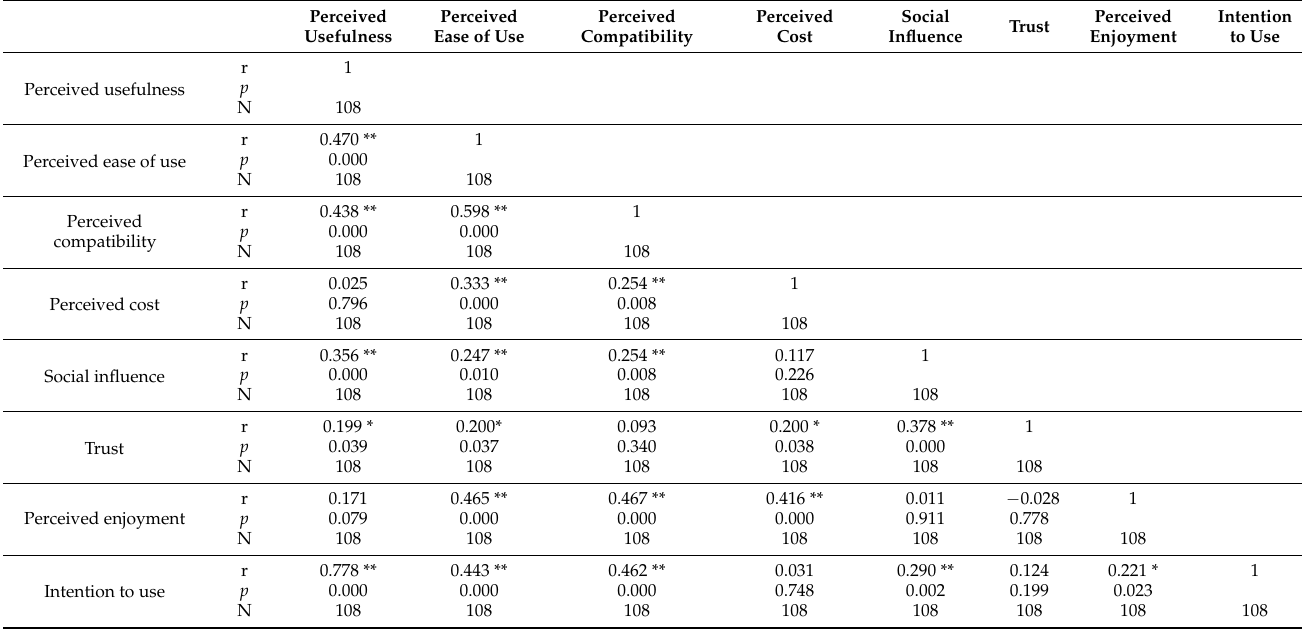
Table A17. Effects of correlation between factors and intention to use smart technology